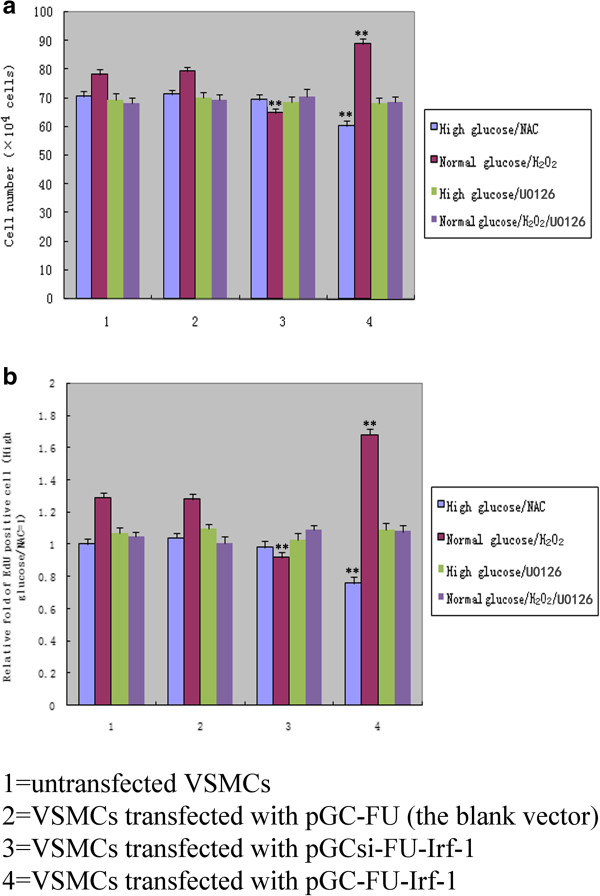
Comparison of cell proliferation in transfected VSMCs following treatment with NAC, H2O2 or U0126. a: cell numbers were counted with a hemocytometer; b: cell proliferation was also measured using the EdU assay; the presented data are the mean ± SD of triplicate determinations repeated in four separate experiments. High glucose/NAC = cells incubated with high glucose and NAC for 5 days; normal glucose/H2O2 = cells incubated with normal glucose and H2O2 for 5 days; High glucose/U0126 = cells incubated with high glucose and U0126 for 5 days; normal glucose/H2O2/U0126 = cells incubated with normal glucose, H2O2 and U0126 for 5 days. *P <0.05; **P <0.01 versus corresponding values in untransfected VSMCs.